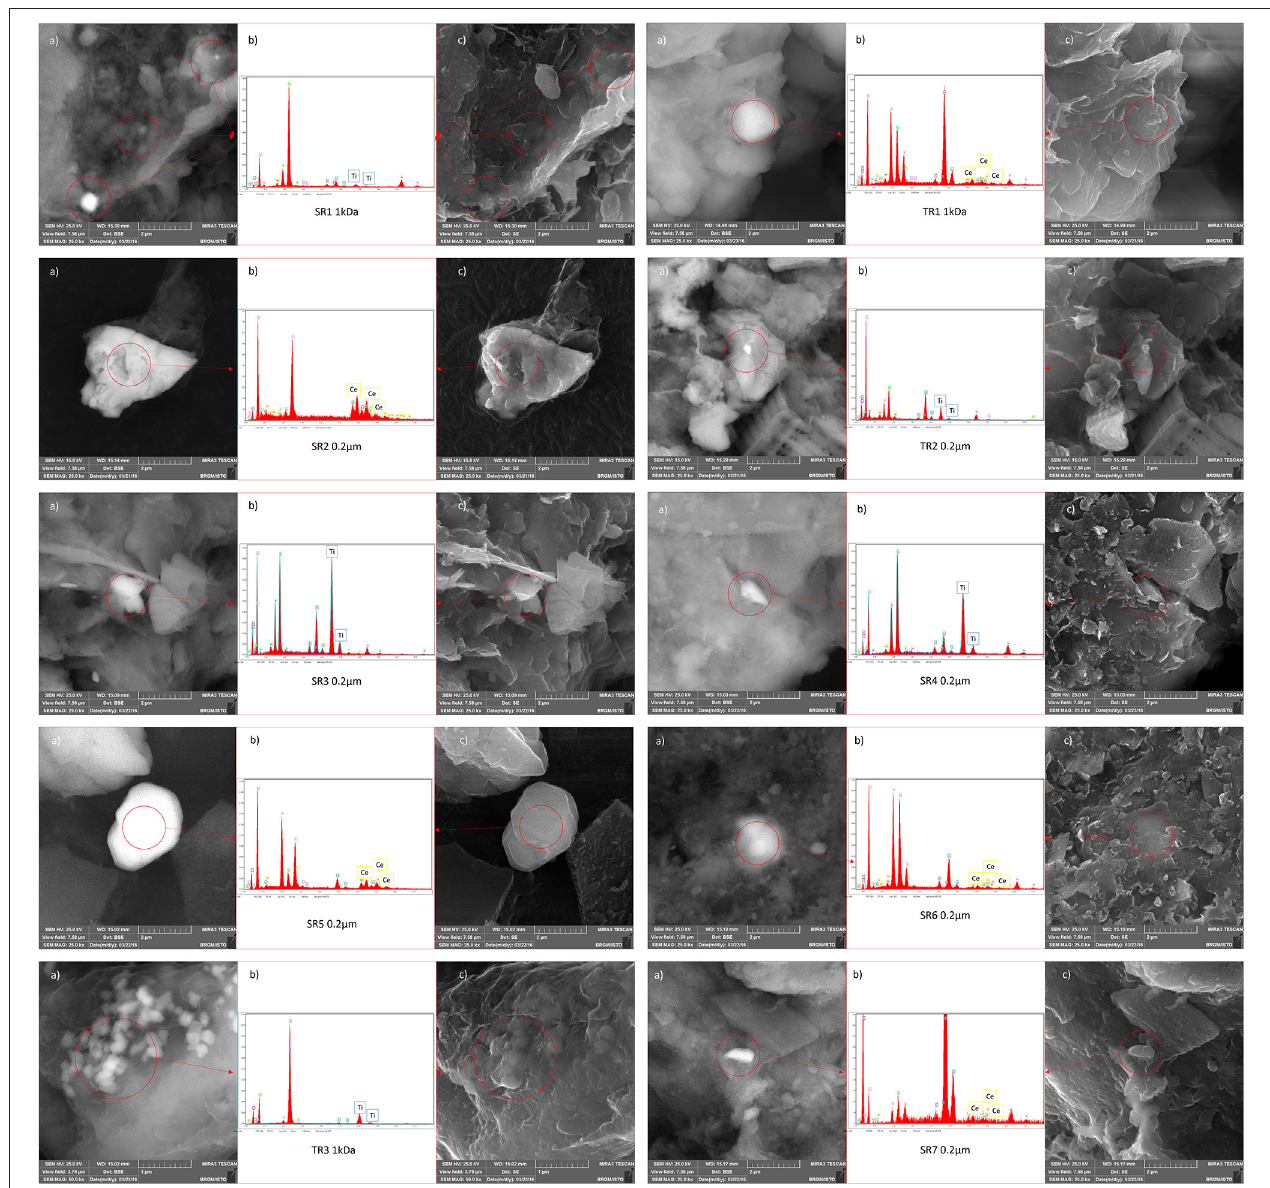
FIGURE 5 | FEG-SEM analyses on either 0.2 micron filter or 1 kDa filter for each of the 10 SPM samples collected; (a) are pictures obtained with BSE detector, (b) represent the corresponding EDS analysis of the target particle(s), and (c) the corresponding SE